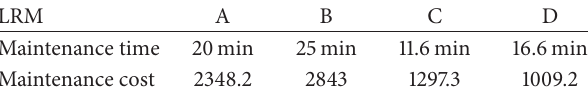
Table 2: The maintenance time of the LRM.